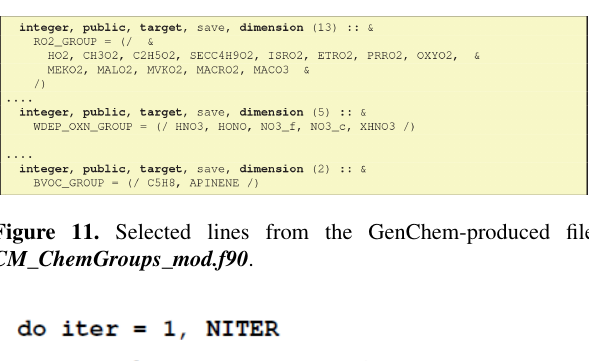
Figure 9. Selected lines from the GenChem-produced file CM_ChemSpecs_mod.f90 .